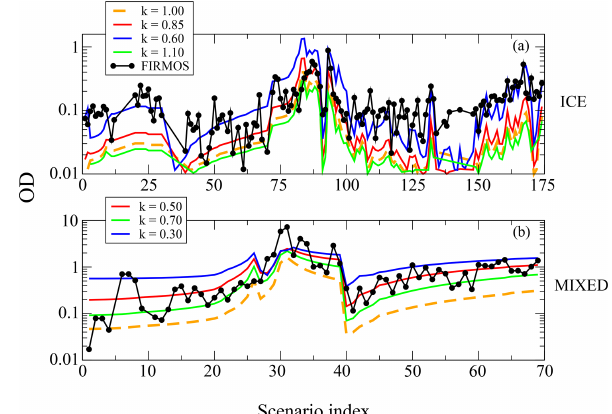
Figure 6. (a, b) The comparison of ice and mixed-cloud ODs re- trieved from FIRMOS (black dots) with those obtained with the Klett approach from lidar measurements. The red lines indicate the retrieved OD by using the k of the best fit, while the green and the blue lines show the variability. The dashed orange lines show the result for k = 1 which is the typical value assumed in other studies.